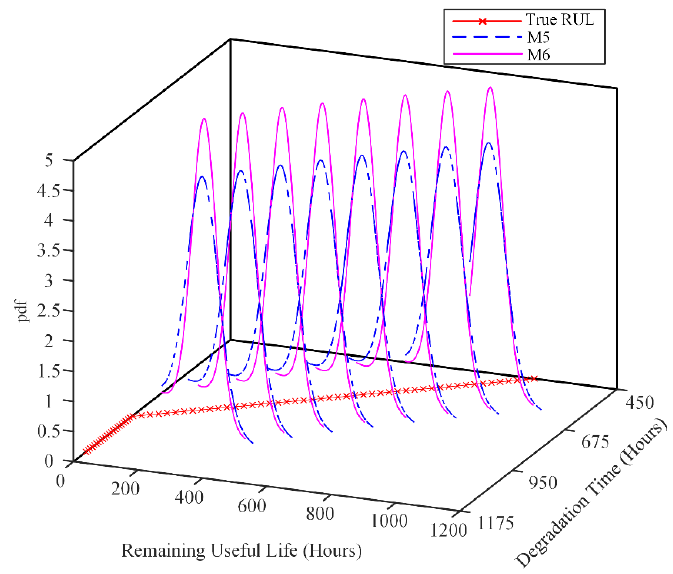
Figure 15. RUL PDF for different models.